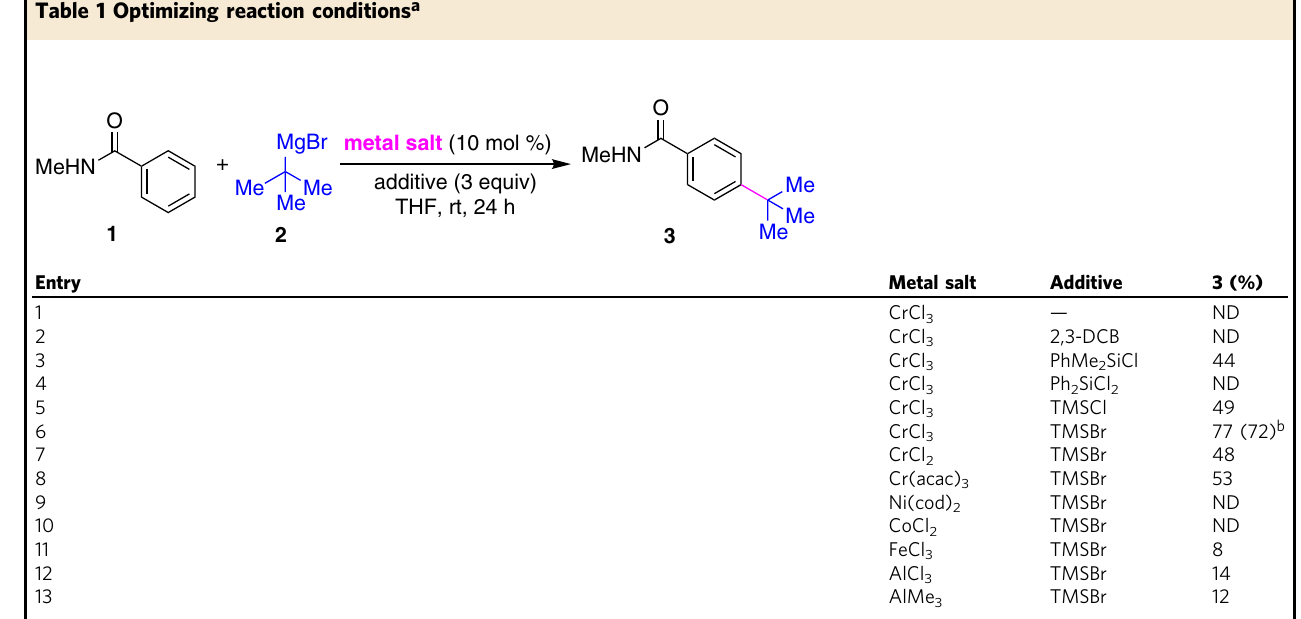
Table 1 Optimizing reaction conditions